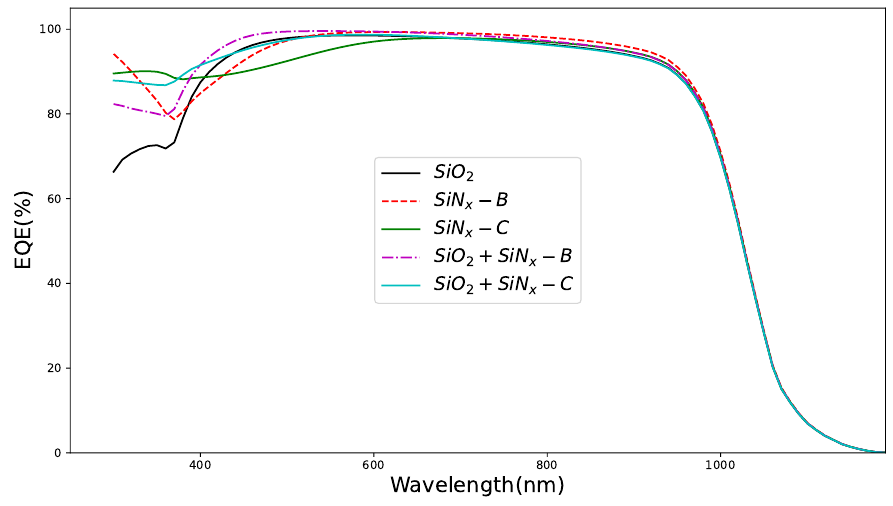
Figure 6. EQE measurement carried on selected ARC